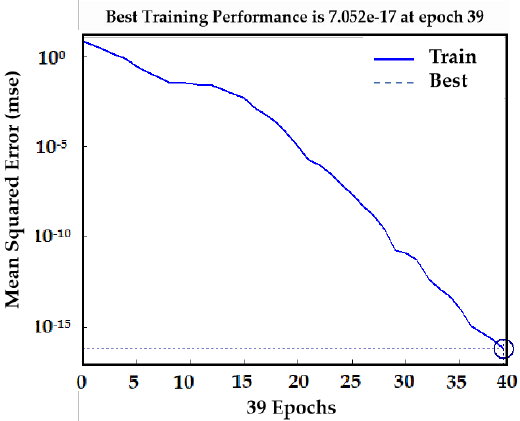
Figure 17. Two-parameter rise-time–amplitude (RA) neural network training performance. Table 14. Rise-time–amplitude (RA) two-parameter neural network prediction results.